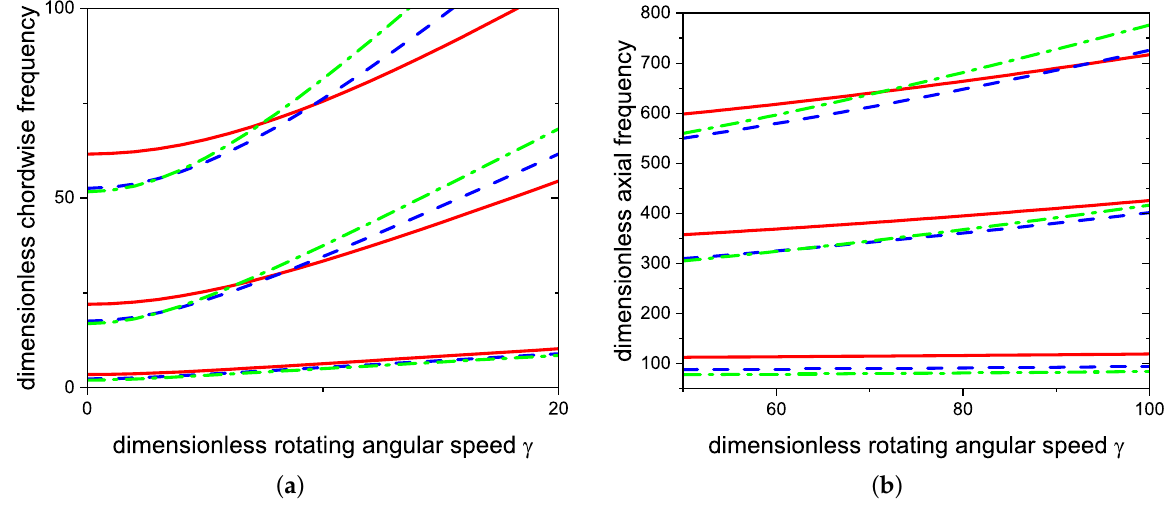
Figure 8. The magnification of the Figure 8: ( a ) Chordwise frequency; ( b ) Axial